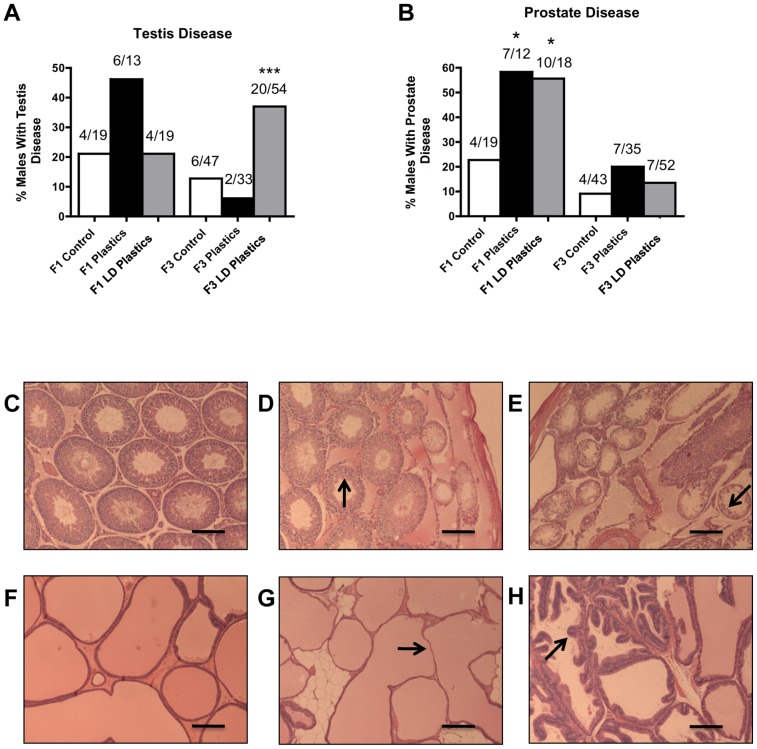
Adult-onset testis disease and prostate disease in males from control, plastics and lower dose(LD) plastics (BPA, DEHP and DBP) lineages. Percentages of males with testis (panel A) or prostate disease (panel B) in F1 and F3 generations are presented. The actual number of diseased rats/total number of rats in each group are shown above the respective bar graphs (* P<0.05; *** P<0.001). Representative micrographs (Scale bar  = 200 μm) showing histopathology images of adult-onset transgenerational testis and prostate disease in plastics (panels D, and G) and lower dose (LD) plastics lineages (panels E and H) compared to F3 control lineage (panels C and F). Testis sections from F3 generation animals in plastics and lower dose (LD) plastics lineages showed histopathology including azoospermic and atretic seminiferous tubules, presence of vacuoles in basal regions of seminiferous tubules, sloughed cells in center of seminiferous tubule and lack of seminiferous tubule lumen (arrows). Prostate sections showed epithelial atrophy and hyperplastic ductular epithelium (arrows).